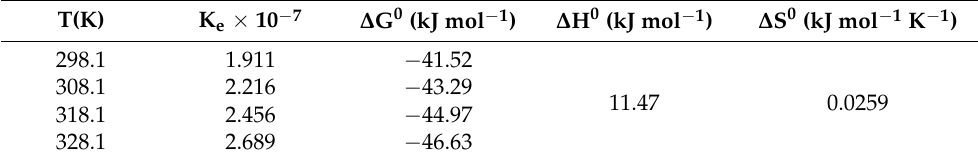
Table 3. Thermodynamic parameters for adsorption of Diuron in